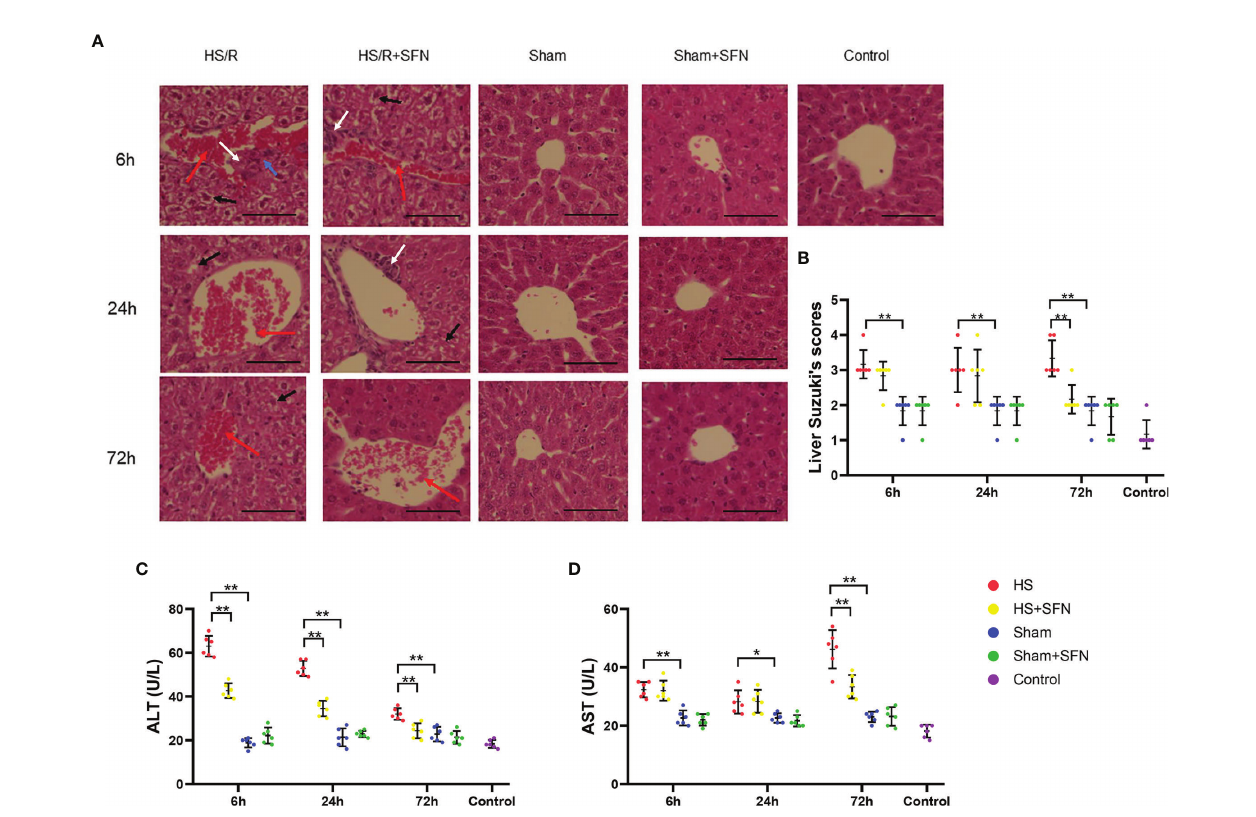
FIGURE 6 | (A) H&E staining liver (n=6 in each group; 200× magni fi cation). H&E staining was performed to visualize cells and determine pathophysiological changes in them (blue arrows: hepatocyte necrosis; black arrows: hepatocyte vacuolation and steatosis; red arrows: portal vein congestion; white arrows: neutrophil in fi ltration). Scale bar = 50 m m. (B) The liver injury score (according to the Suzuki standard). The liver injury score was calculated according to the scoring system that ranged from 0 to 5, as mentioned above. Every fi eld of the sample was evaluated by two independent observers (*p < 0.05, **p < 0.01; Kruskal-Wallis test followed by Dunn ’ s post hoc test). ALT (C) and AST (D) levels in C57/BL6 WT mouse plasma were expressed in U/L as mean ± SD. (n=6 in each group; *p < 0.05, **p < 0.01; One-way ANOVA followed by Tukey ’ s post hoc